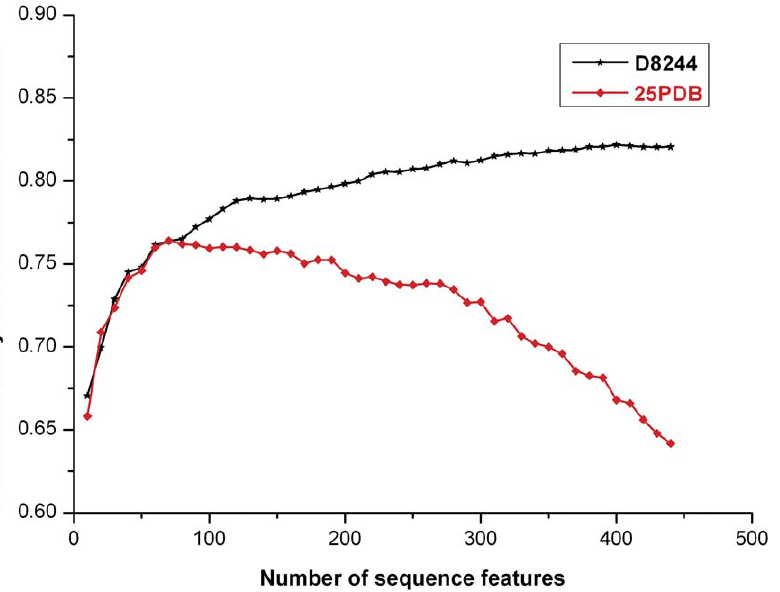
Figure 2. The effect of the number of sequence features used on the overall prediction accuracies for the two datasets 25PDB and D8244.